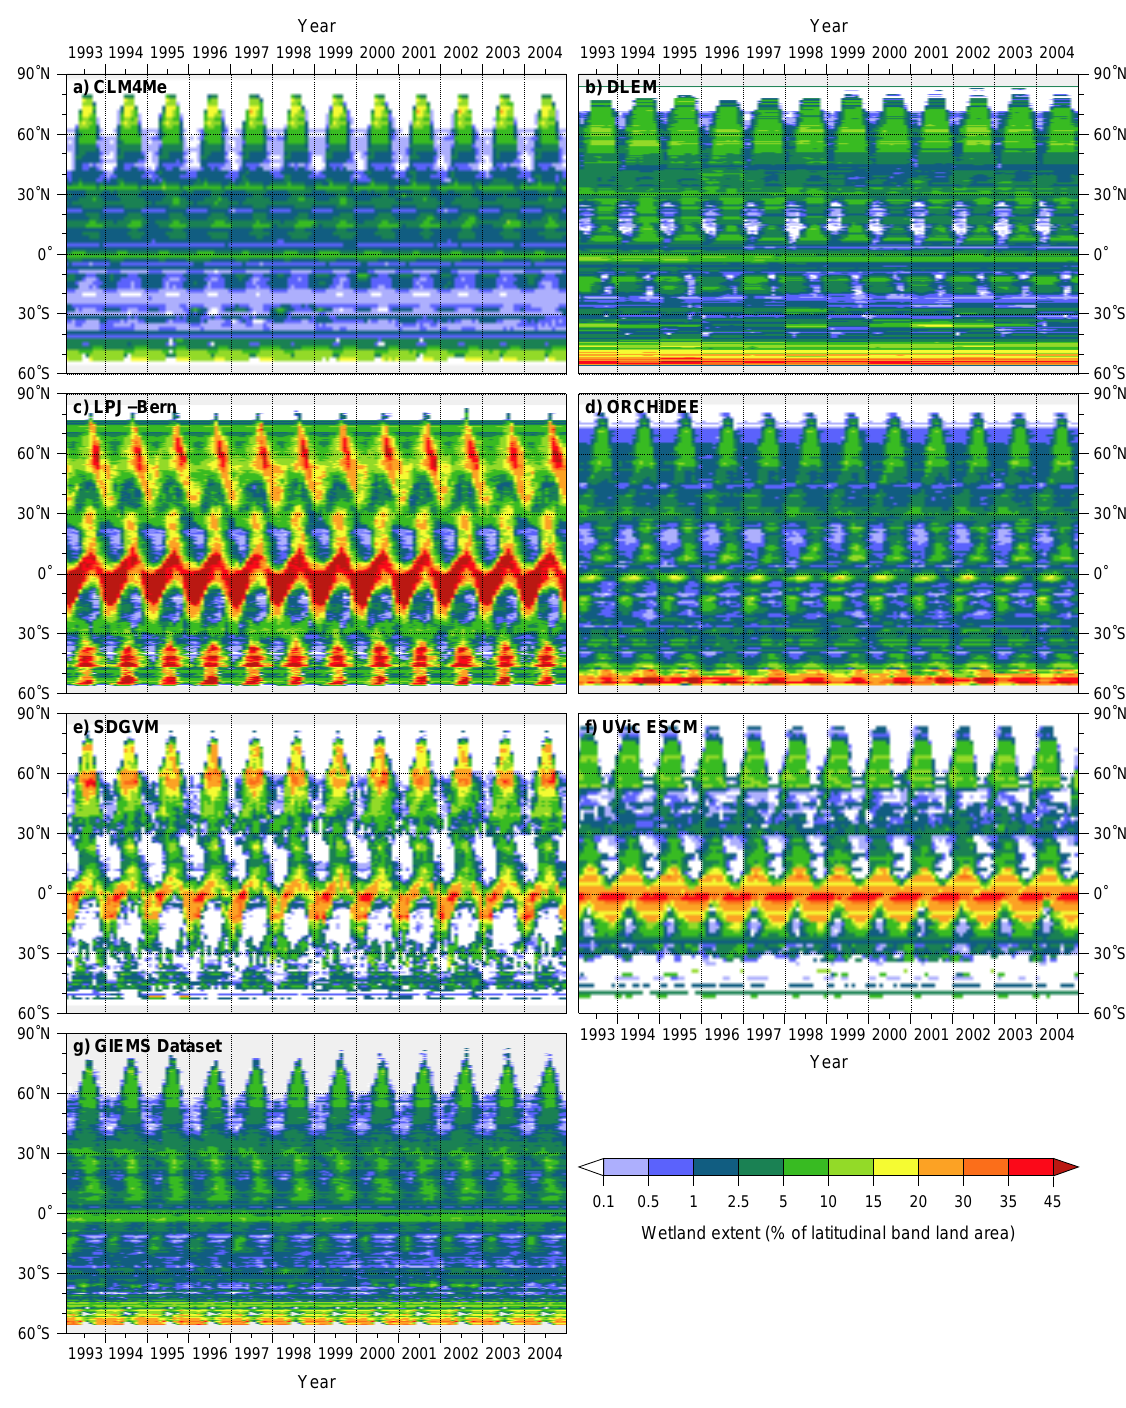
Fig. A2. Monthly zonally averaged wetland area for 1993–2004 for all models that have independent calculation of intra-annual variability. The inundation dataset, GIEMS, is included as an approximate observed wetland